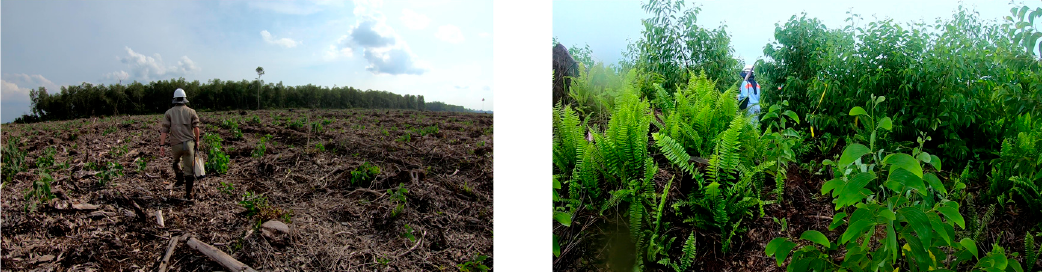
Figure 1. Example of temporal differences for fast-growing species. The left image shows the fast-growing Acacia trees in its early stages in August, 2018, while the right image shows its rapid growth in October, 2018. Even with small temporal differences, the situation of the land area would change dramatically.